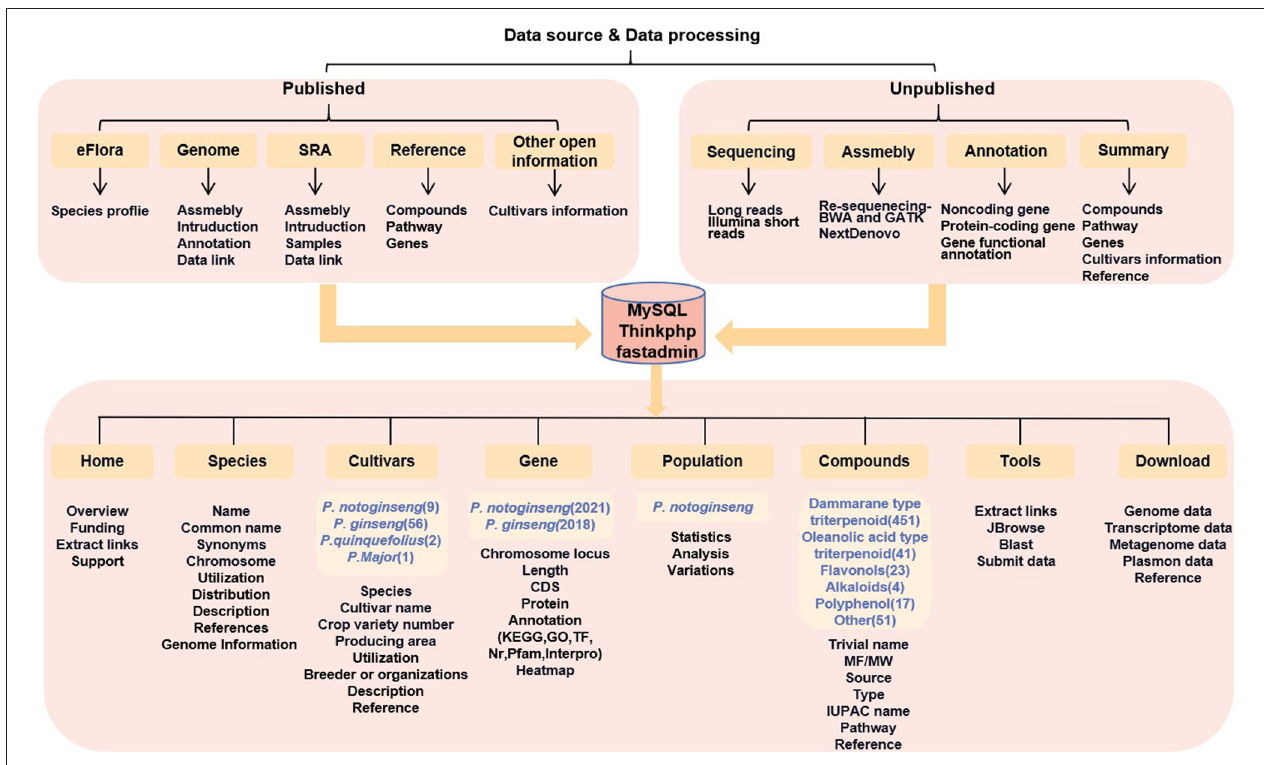
FIGURE 1 | A schematic diagram of the architecture of the PanaxGDB.